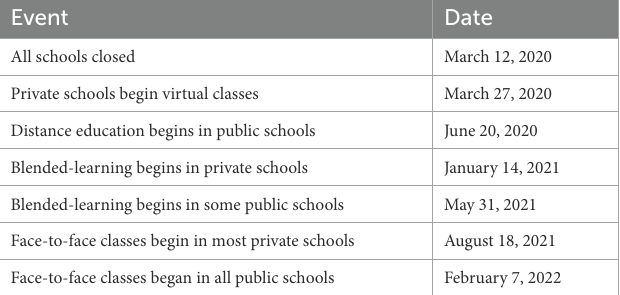
TABLE 1 Timeline of education during the pandemic in